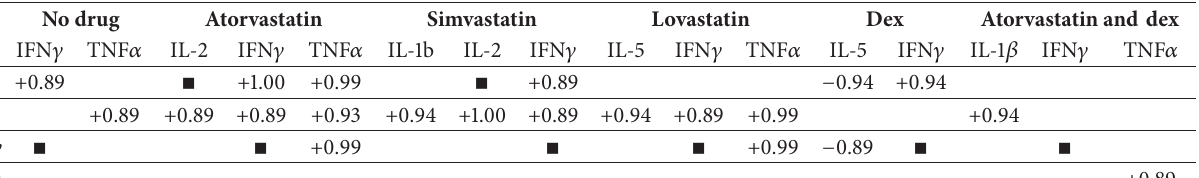
Table 1: Spearman rank analysis of correlations in cytokines produced by cells cultured with PMA/ionomycin ± statins ± dexamethasone. The values represent the strength of the correlation of cytokines, with +1.00 being the maximum, and their changes in expression according to exposure to each statins. All results were statistically significant ( 𝑃 < 0.04 ).